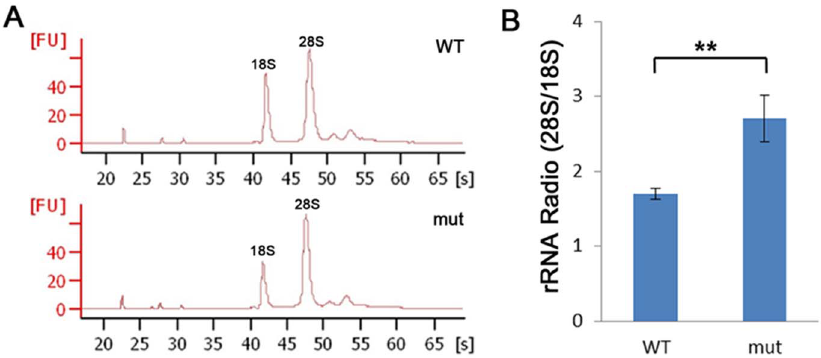
Figure 6. dg5 nom1 larvae display defects in ribosome biogenesis. (A) Bioanalyser analysis of total RNA isolated from WT and mutant group at 3 dpf reveals a reduction of the 18S rRNA production but relative normal 28S rRNA amount. (B) The relative rRNA ratio (28S/18S) is elevated in the dg5 nom1 as compared to WT. Error bars mean 6 SD. ** P , 0.01.